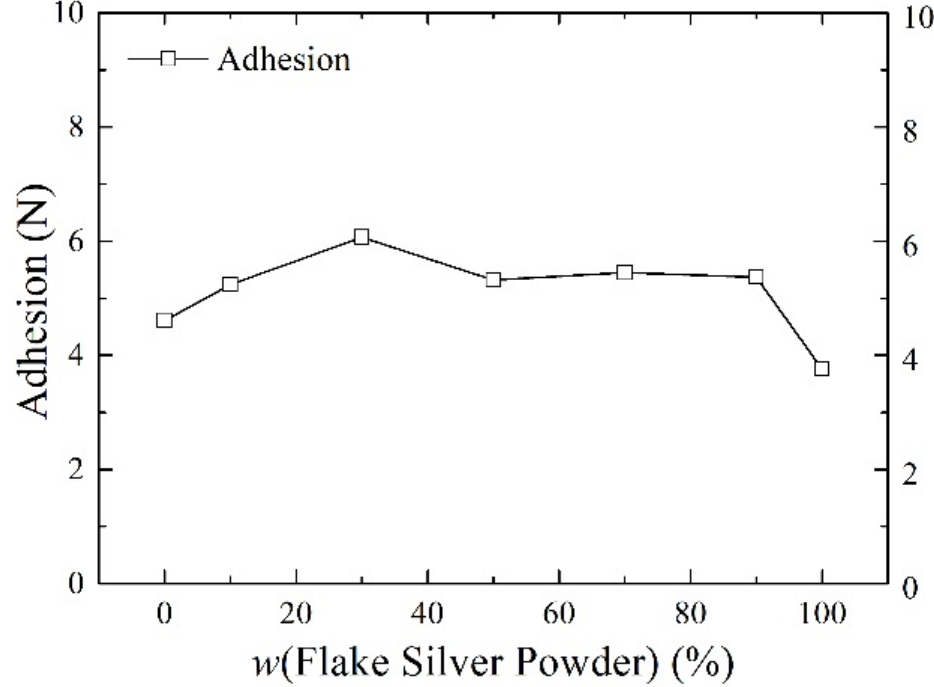
Figure 7. The effect of the flake silver powder content on the adhesion of the sintered silver film.